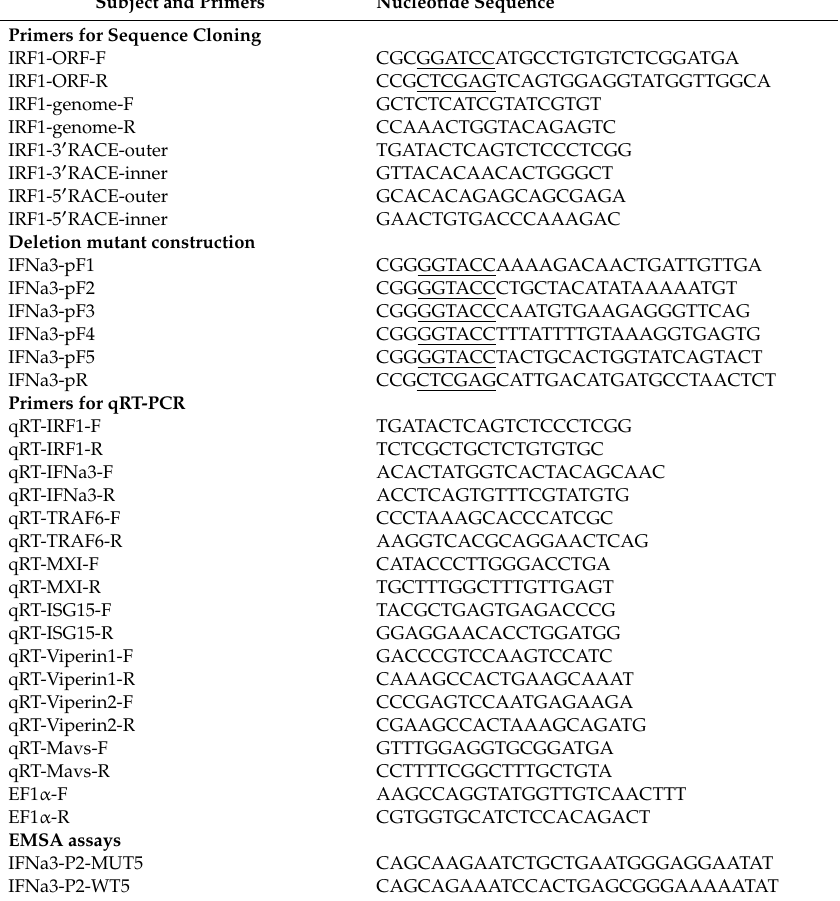
Table 1. Primers used for sequence cloning, deletion mutant construction, mRNA construction, and qRT-PCR [5,28,29]. RACE—Rapid Amplification of complementary DNA (cDNA) Ends; EMSA—electrophoretic mobile shift assay.